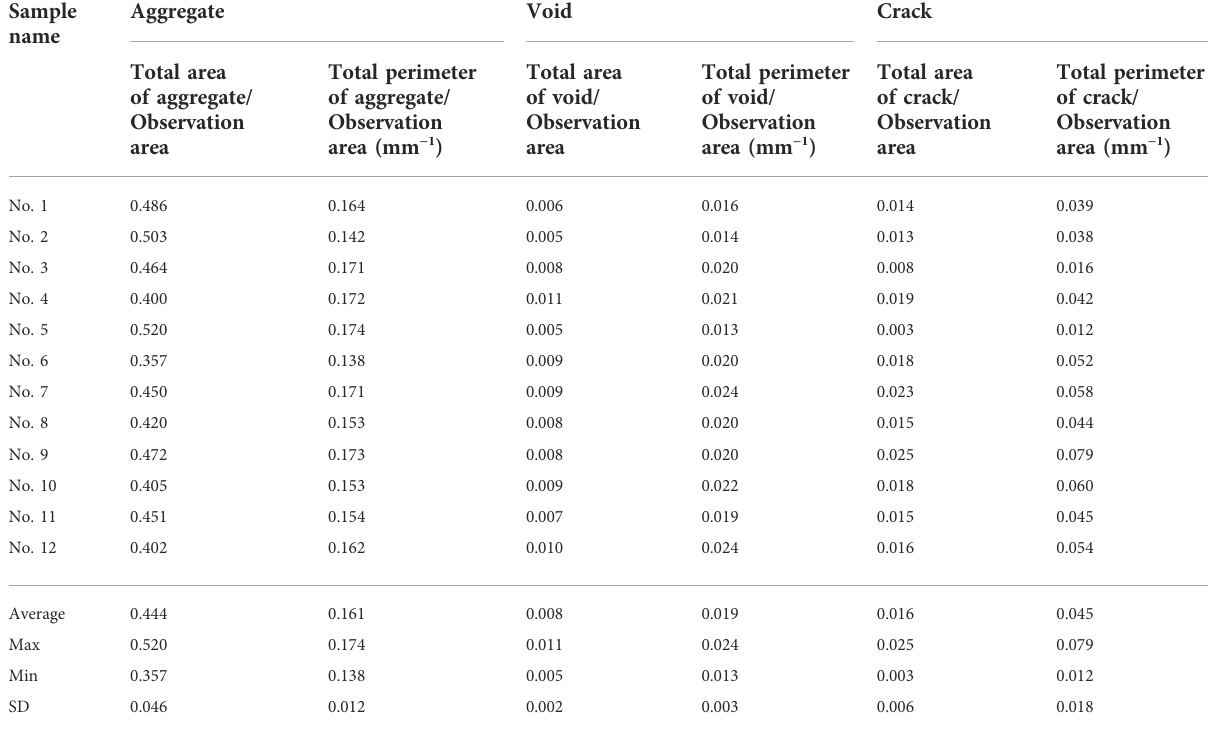
TABLE 5 Proportions of concrete